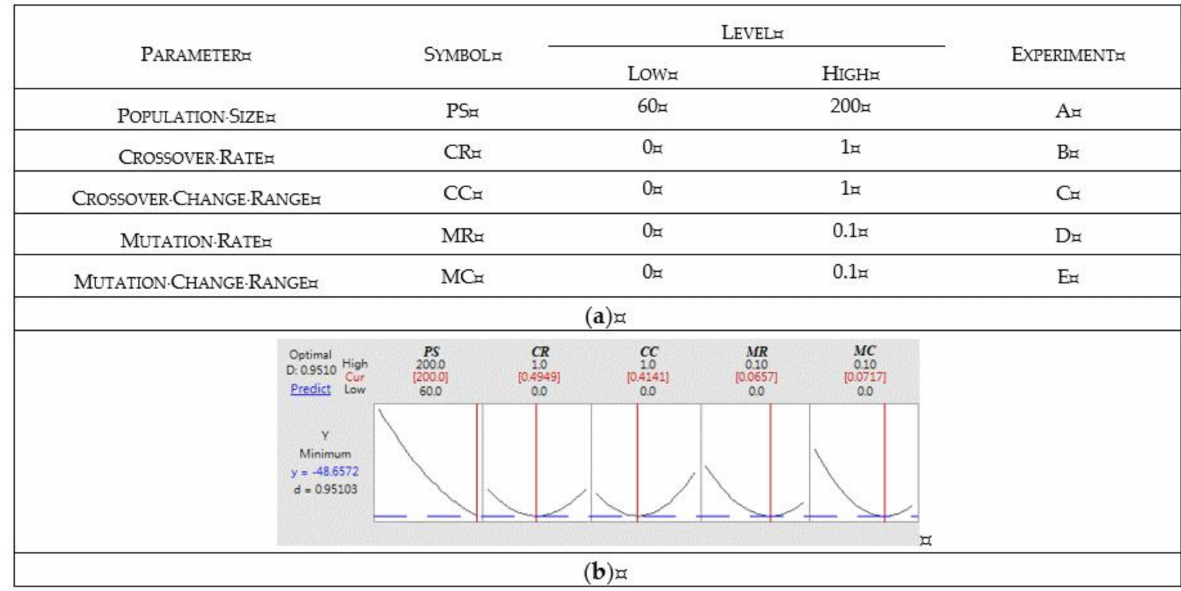
Figure 2. Algorithm parameter calibration: ( a ) factor levels, ( b ) response analysis.